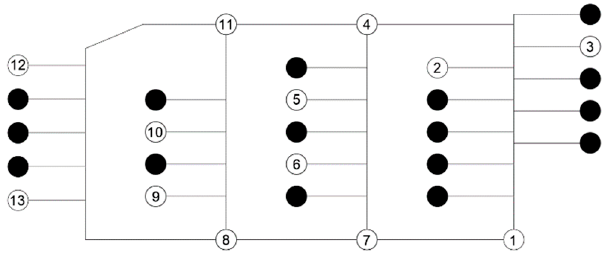
Figure 6. Parking lot occupancy.